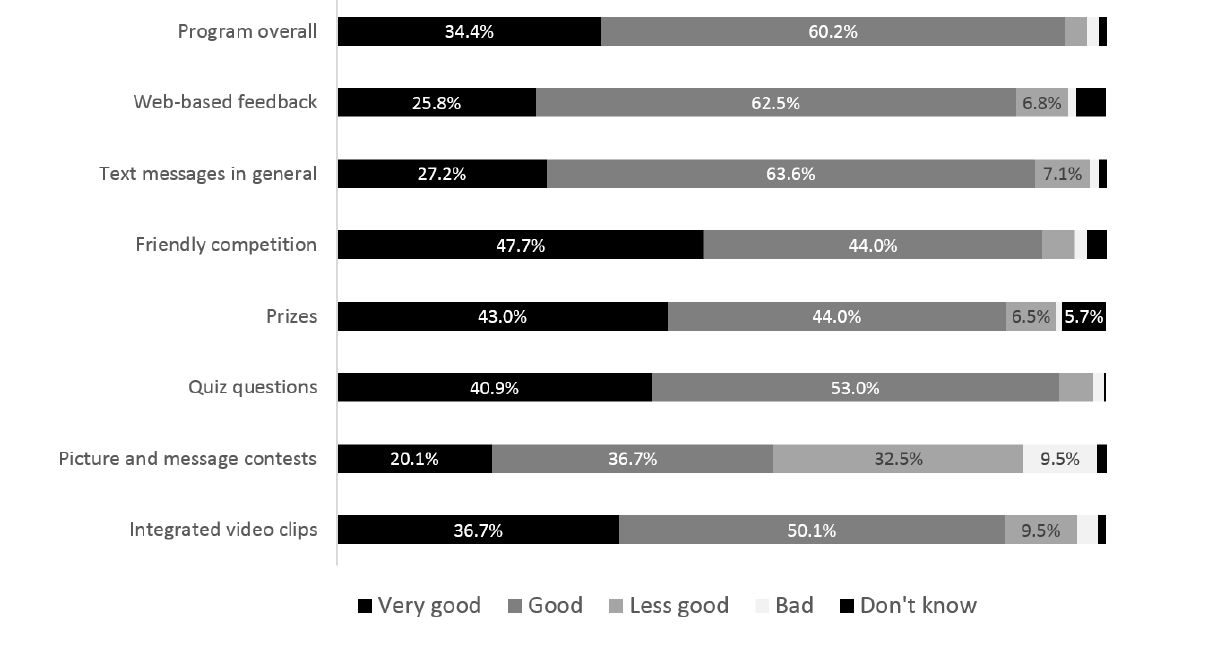
Figure 4. Evaluation of the program and specific program elements by program participants (n=384). Values are presented for percentages >5%.